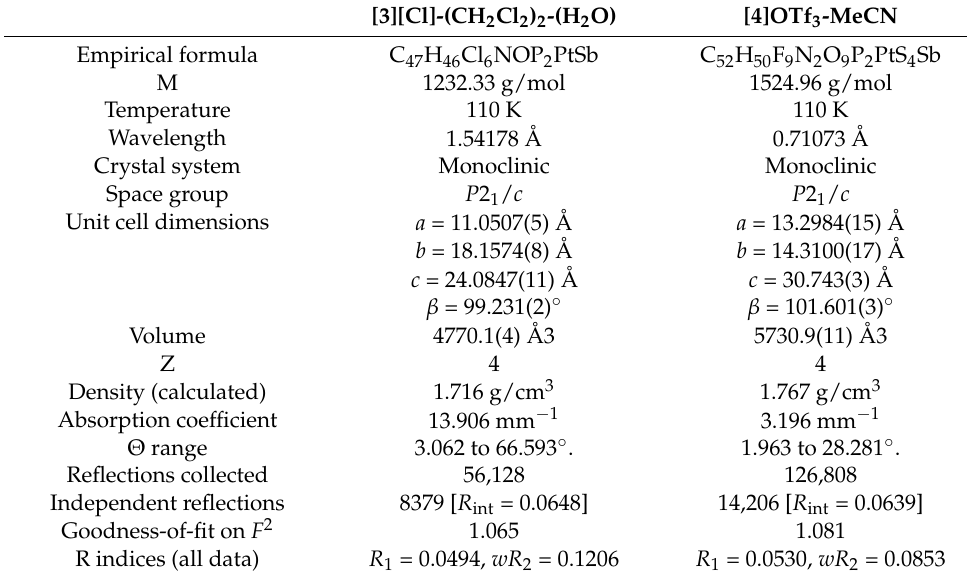
Table 1. Crystal data and structure refinement for [ 3 ][Cl] and [ 4 ]OTf 3 1